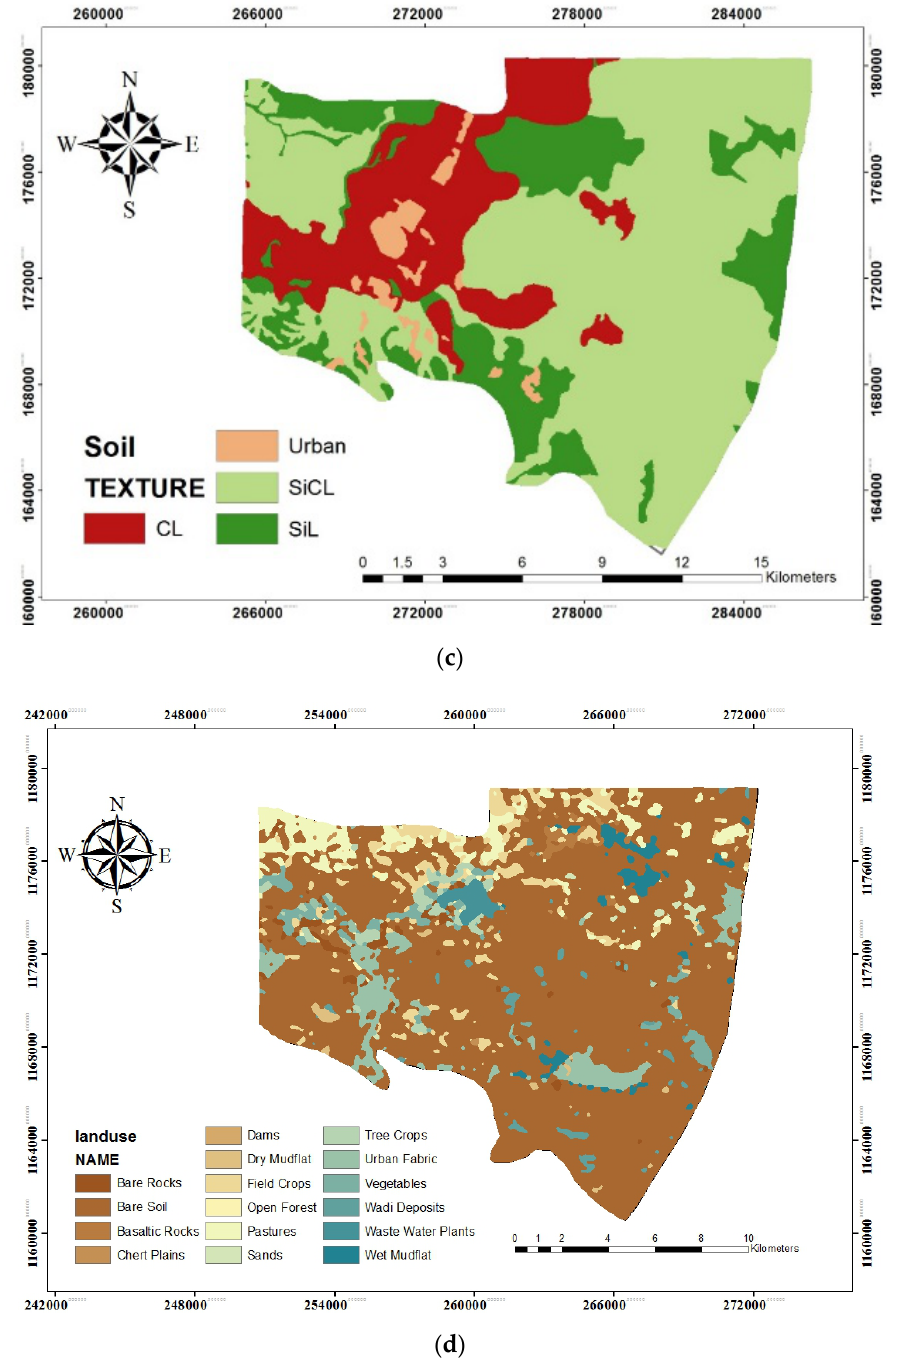
Figure 2. ( a ) Digital Elevation Model. ( b ) Water level contour map in 1965. ( c ) Soil Texture. ( d ) Land Use.